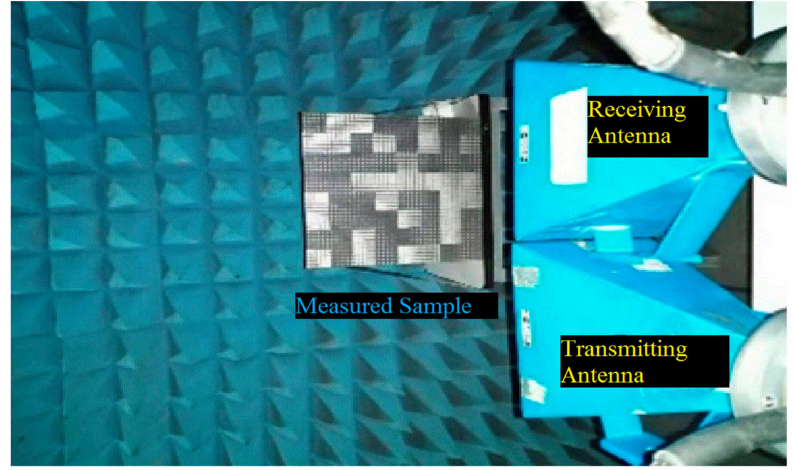
Figure 10. Experimental setup.